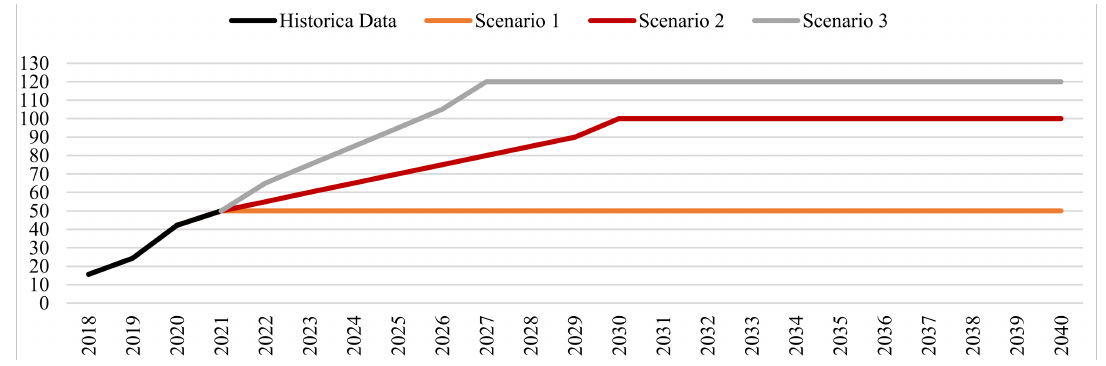
Figure A1. Projection of CO2 Price evolution € /t, Source: Authors’ projections.